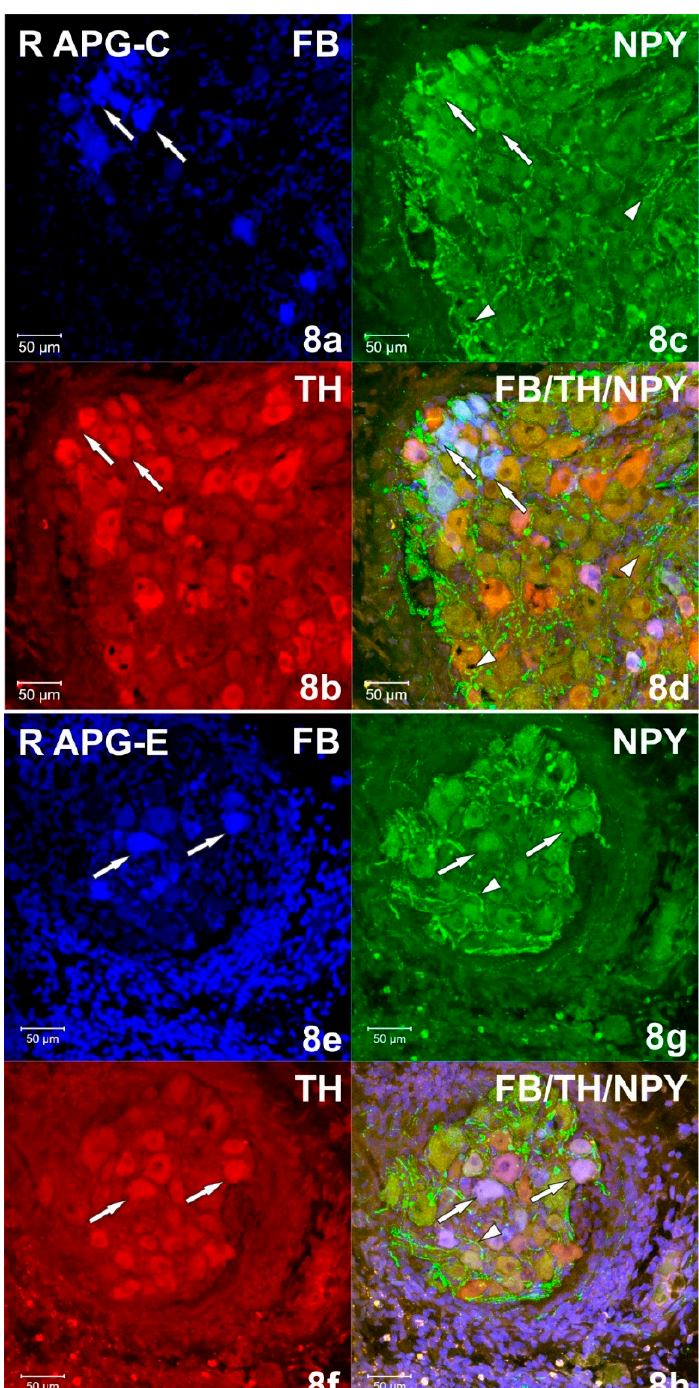
Figure 8. ( a – d ) Confocal laser scanning microscope images showing a section of the right (R) APG from the control (C) group. FB+ ( a ) neurons simultaneously immunoreactive ( d ) against TH ( b ) and NPY ( c ) marked with arrows. The arrows indicate single, varicose NPY-IR fibers ( c , d ). The images were taken from blue, green and red fluorescent channels. Blue, green and red channels were digitally superimposed. Scale bar = 50 µm. ( e – h ) Confocal laser scanning microscope images showing a section of the right (R) APG from the experimental (E) group. Arrows indicate FB+ ( e ) TH-positive ( g ) neurons and NPY-IR ( f ). Numerous NPY-IR fibers ( g , h ) marked with an arrowhead. The images were taken from blue, green and red fluorescent channels. Blue, green and red channels were digitally superimposed. Scale bar = 50 µm.